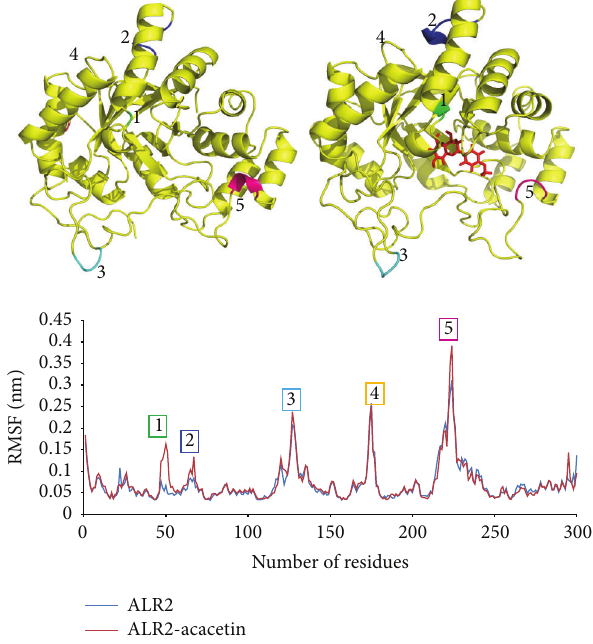
Figure 7: Root mean square fluctuation (RMSF) plot of apo- and complex forms along with the conformational changes in the respective structures (apo-form left and docked complex right) denoted by corresponding peak